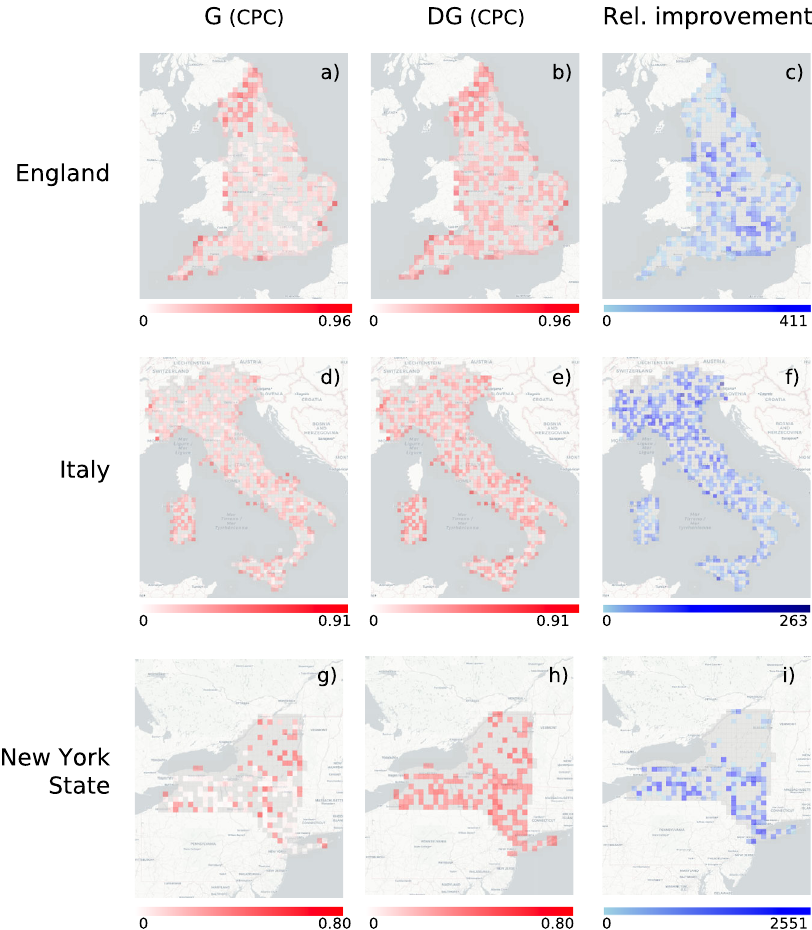
Fig. 3 Performance of the models. Common Part of Commuters (CPC) by region of interest (side size of 25 km) in England ( a , b ), Italy ( d , e ), and New York State ( g , h ) according to the gravity model (G) and Deep Gravity (DG). The CPC in each region of interest is the average CPC over the runs in which that region of interest has been selected in at least one test set. Gray regions of interest have never been selected in the test set. ( c , f , i ) Average relative improvement over fi ve independent experiments in terms of CPC (in percentage) of DG with respect to G for each region of interest of side size 25 km in England, Italy, and New York